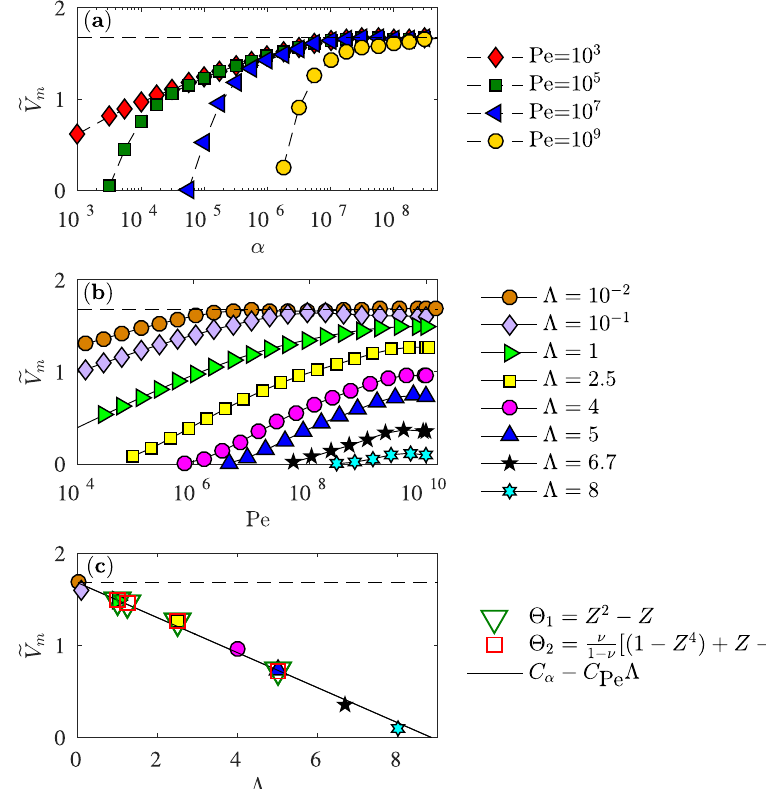
Figure 6. Asymptotic behavior of e V m = V m α − 1 for the case without subtemperate slip. In this case we expect a limiting behavior of + β) α − 1 ; see Eq. (41). Panel (a) : e V m = e f ((cid:51)) for α (cid:29) 1 and (cid:51) = Pe 1 /( 1 e V m against α for different values of constant Pe . Convergence to a constant value confirms the limiting behavior predicted by Eq. (41). Panel (b) : e V m against Pe for different values of (cid:51) . Note that holding (cid:51) constant as Pe changes implies that α changes proportional to Pe 1 /( 1 + β) . Panel (c) : e V m against (cid:51) at constant Pe = 10 10 , corresponding to different values of e f ((cid:51)) . Filled markers show the same data as in panel (b) . The open triangles and squares additionally show results for two different temperature fields in the ridge far field with same non-dimensional bed temperature (cid:50) = 0 at Z = 0, as indicated in the legend.